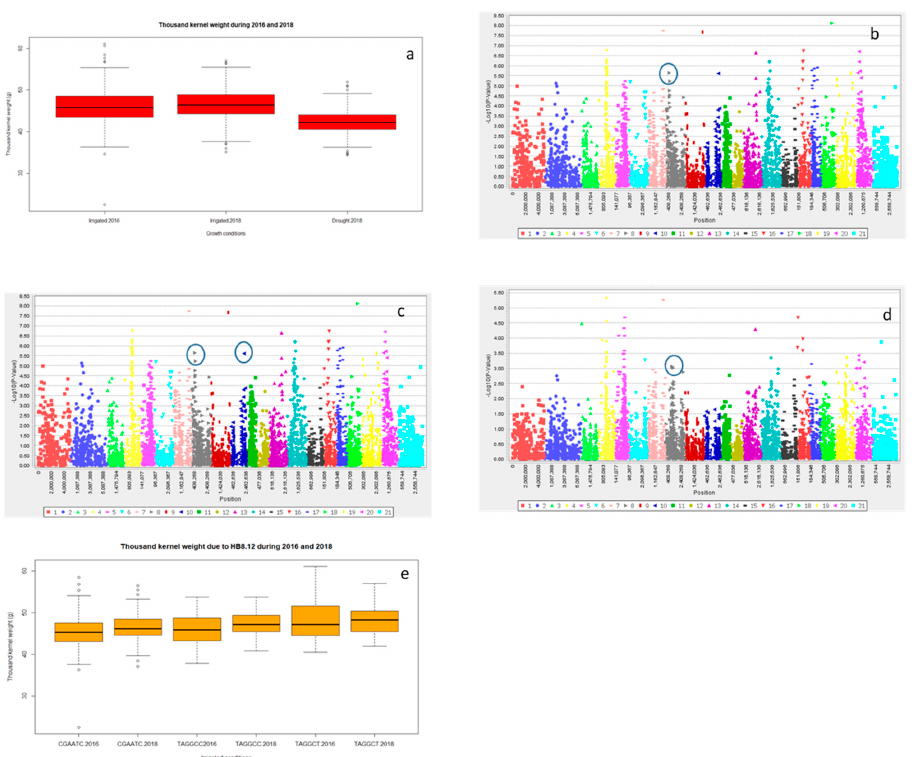
Figure 5. Boxplot showing variation for thousand kernel weight under irrigated conditions 2016 and irrigated and drought condition for 2018 ( a ). marker trait association through GLM under irrigated 2016 ( b ), irrigated 2018 ( c ) and drought ( d ) conditions 2018. HB 8.12 showing differences in thousand kernel weight under irrigated conditions for 2016 and 2018 ( e ).